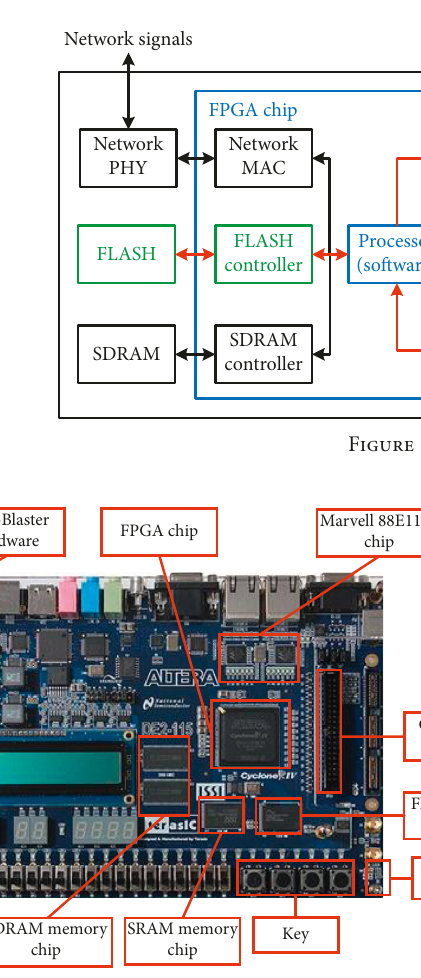
Figure 9: FPGA development board (reproduced from Tsai et al.